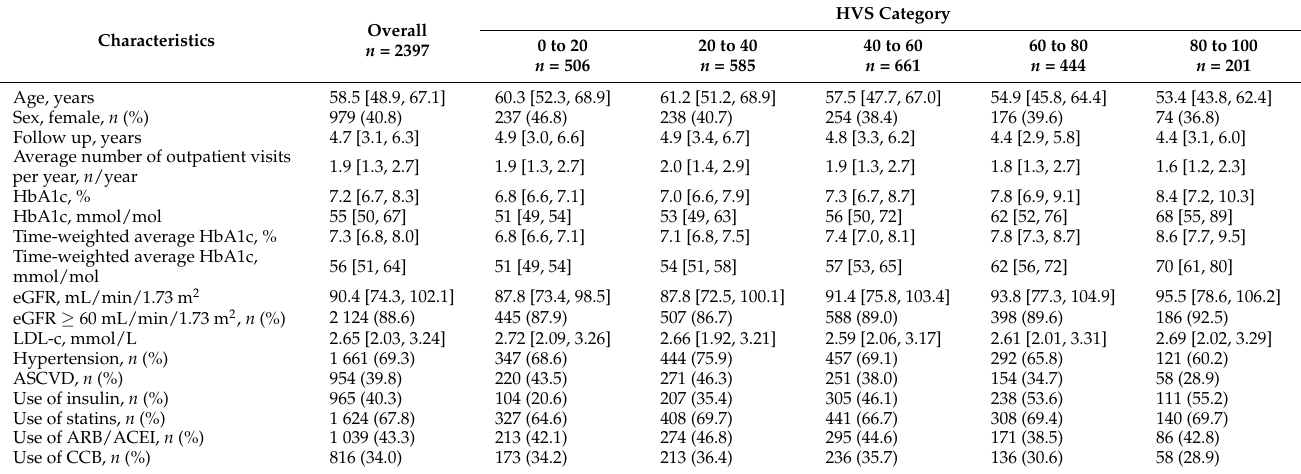
Table 1. Baseline characteristics of the study